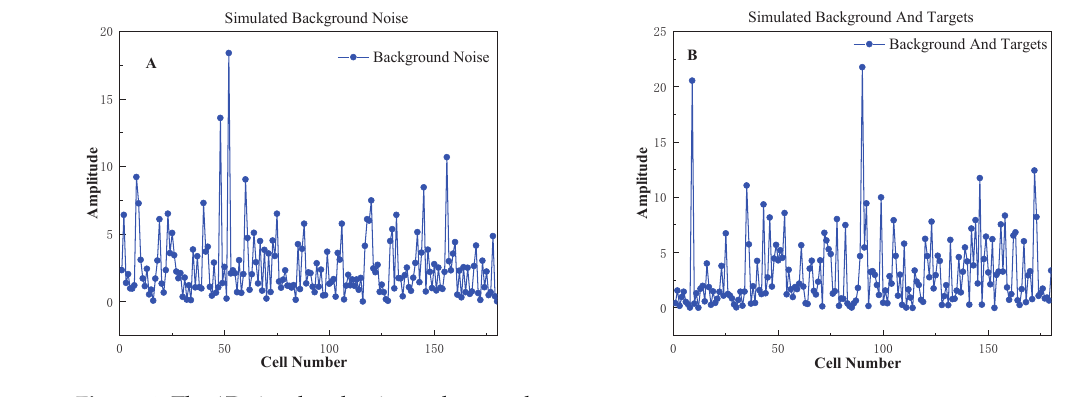
Figure 4. The 1D simulated noise and target